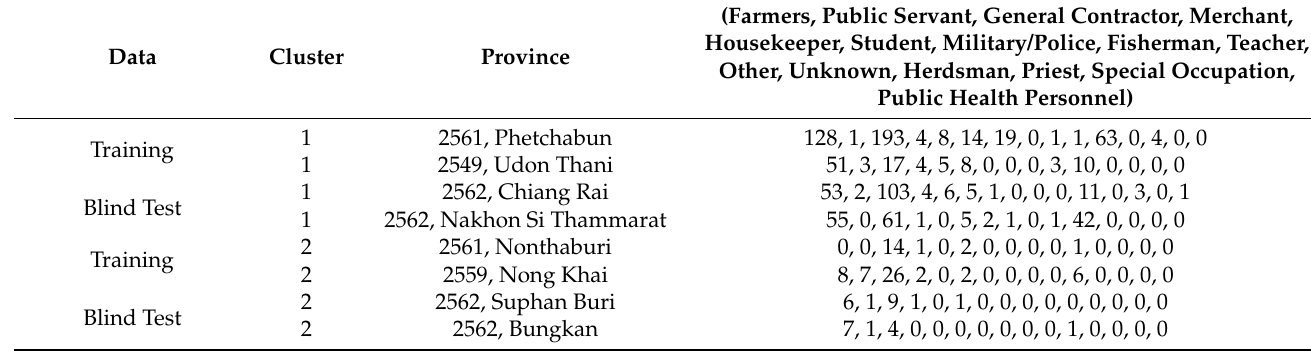
Table 16. The example of clustering results from the selected models for the HBV dataset for the career